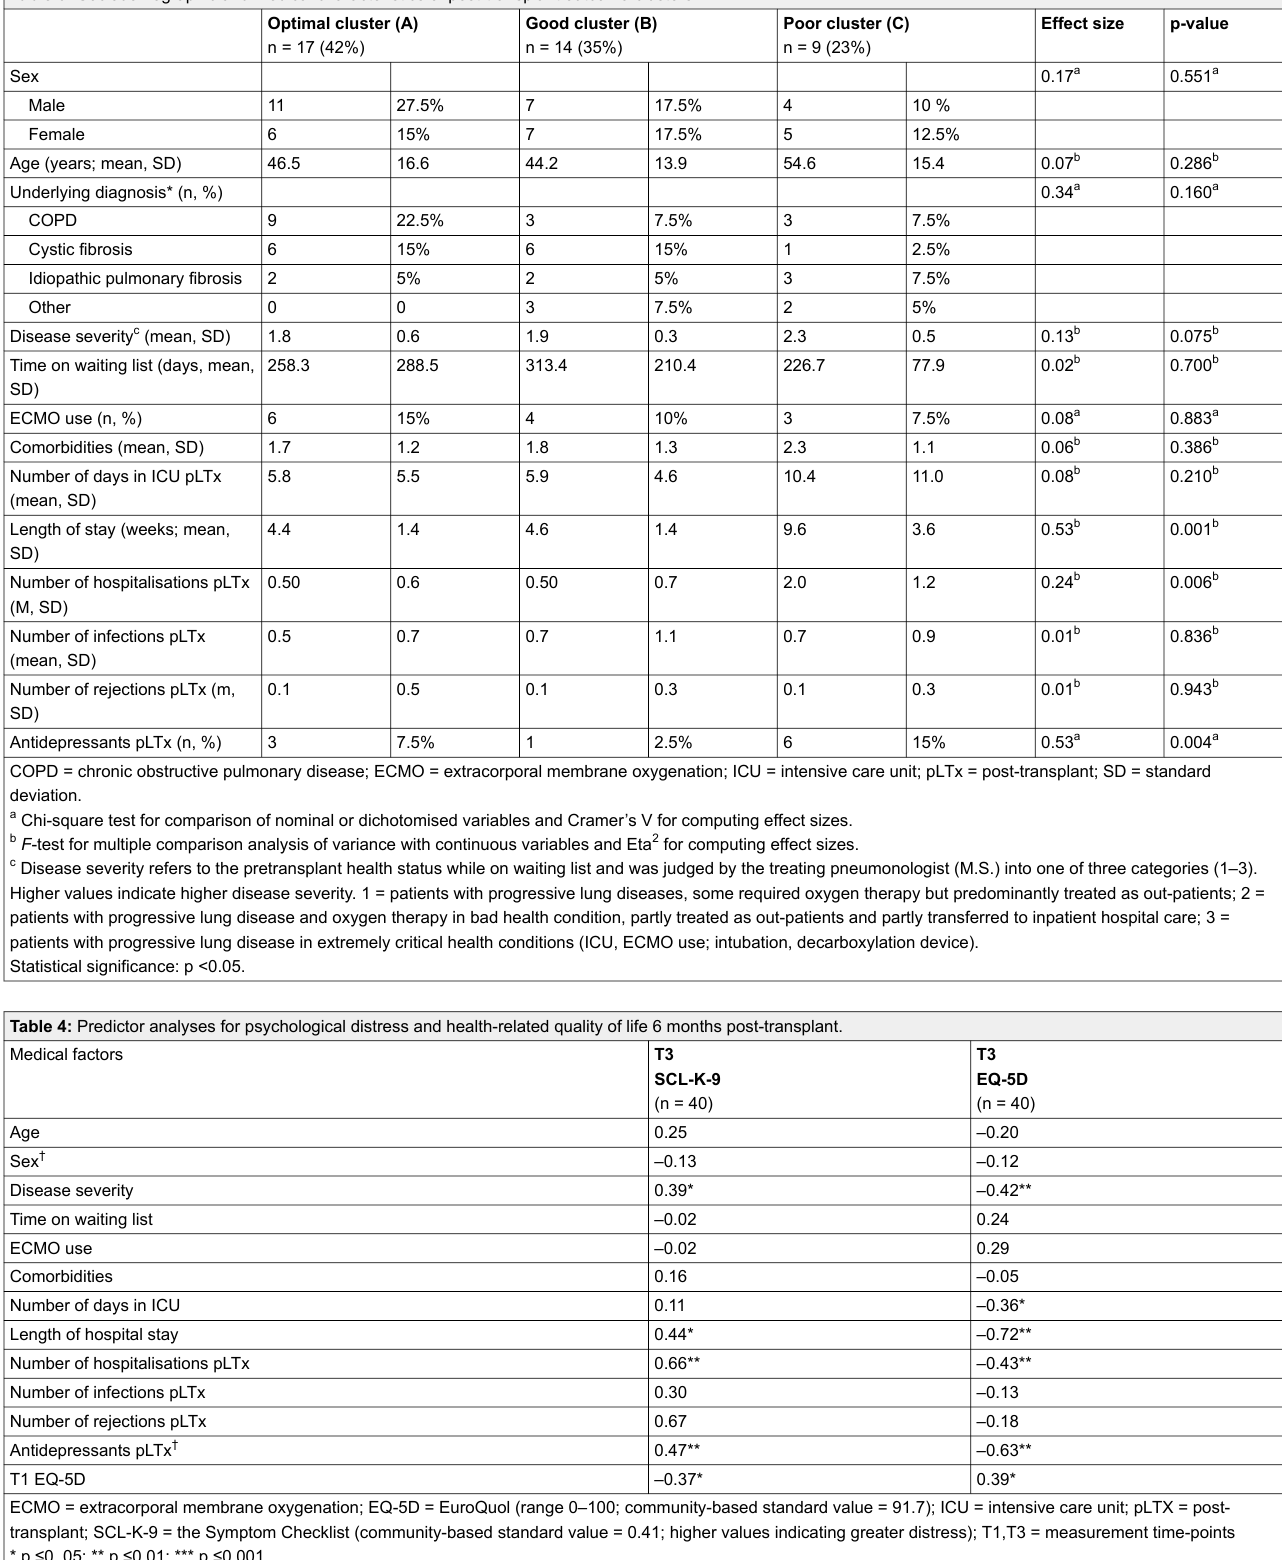
Table 3: Sociodemographic and medical characteristics of post-transplant outcome-clusters.